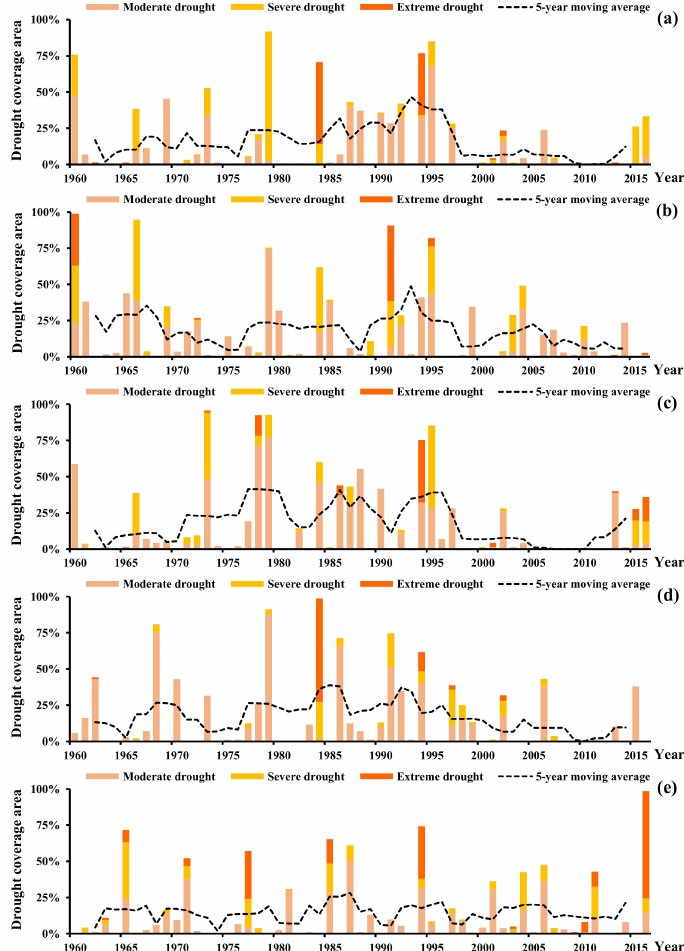
Figure 6. Percentages of drought affected areas for ( a ) year; ( b ) spring; ( c ) summer; ( d ) autumn; ( e ) winter.